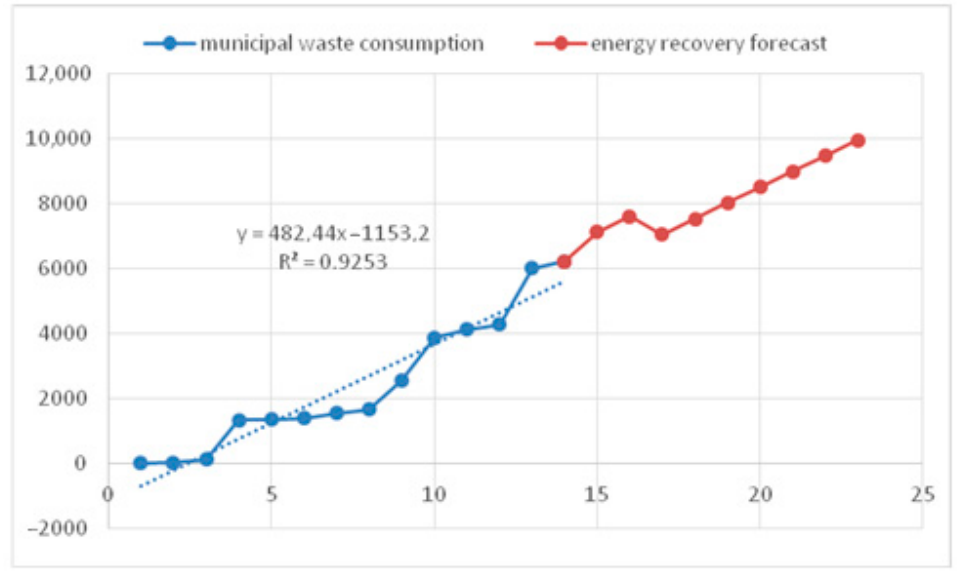
Figure 7. Prediction of energy recovery from biodegradable municipal waste (in TJ).